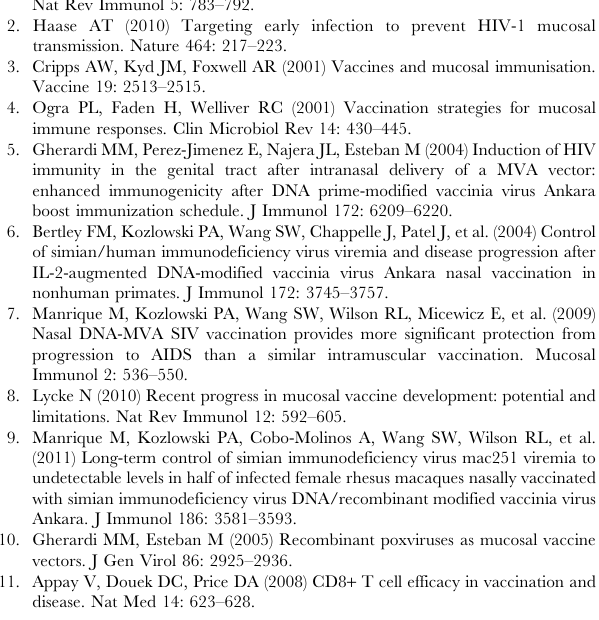
Figure S2 Specific humoral immune response against gp-120 in mice immunized with mucosal adjuvants. Ten days after the MVA boost, antibody levels against gp-120 were quantified by ELISA in sera (A and B) andvaginal washing (C) samples from immunized mice. (A) specific IgG absorbances, dotted line represents cutt-off for positive responses (B) IgG1/IgG2a absorbance ratios. In A and B, each point represents the mean absorbance values of duplicate determinations of individual sera from four mice per group diluted 1:50. (C) HIV-1 gp120 specific IgA levels were quantified in vaginal washings of pooled samples from 4 to 6 mice per group diluted 1:5. Data represent the mean fold increments in the absorbance values of pooled vaginal washings samples of the different experiments, respect to those values detected in pre- immune mice samples. Cut off to consider positive samples were values $ to mean values found in naı¨ve samples plus 3SD. *: Statistical differences between groups (p , 0.05). NS: Non signif- icant differences respect to the control group by Mann-Whitney